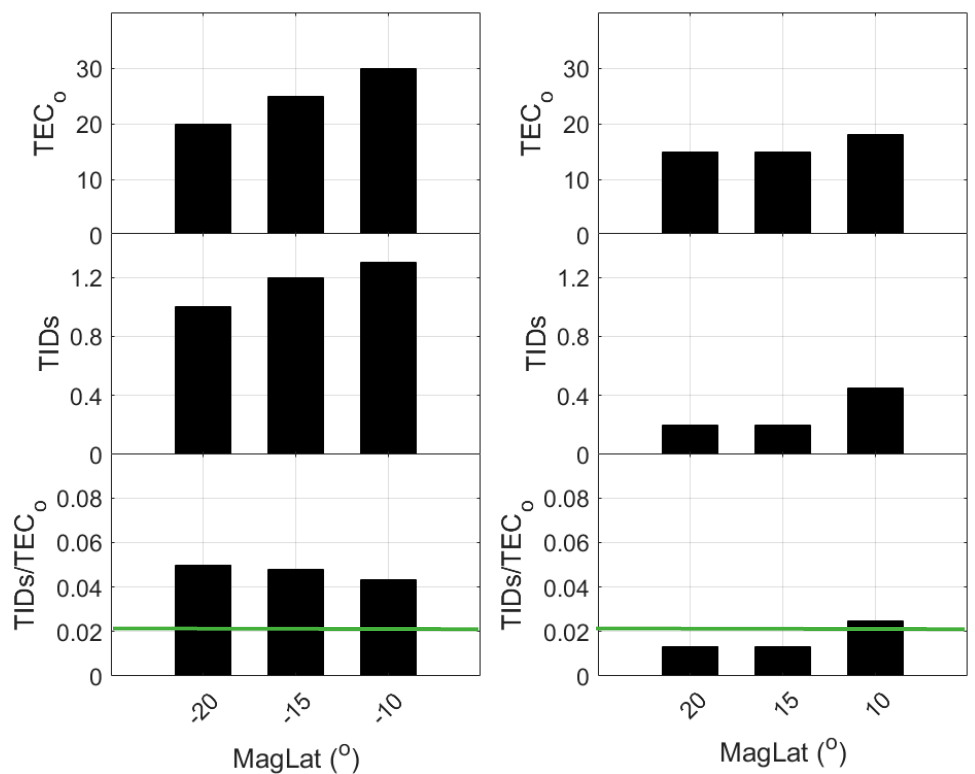
Figure 10. The left panels show the background TEC (TECo), TIDs, and TIDs / TECo for the southern hemisphere, and the right panels show the same parameters for the northern hemisphere. All the parameters (except for the parameter represented by the bottom panels) are represented in TECU where 1 TECu = 10 16 electron / m 2 .